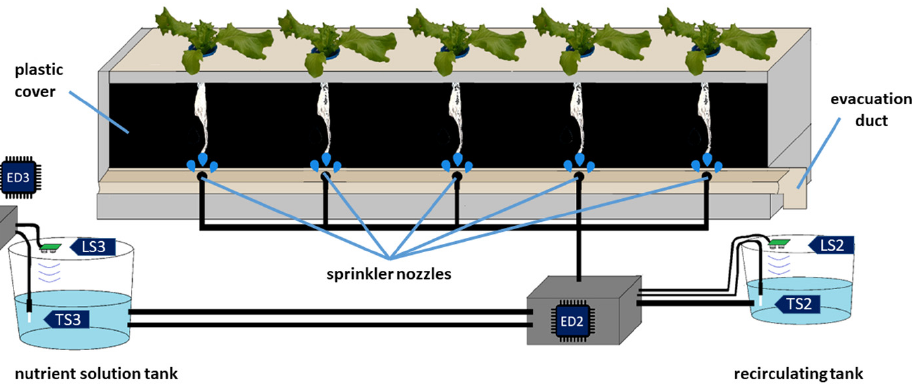
Figure 1. Aeroponic growing chamber.